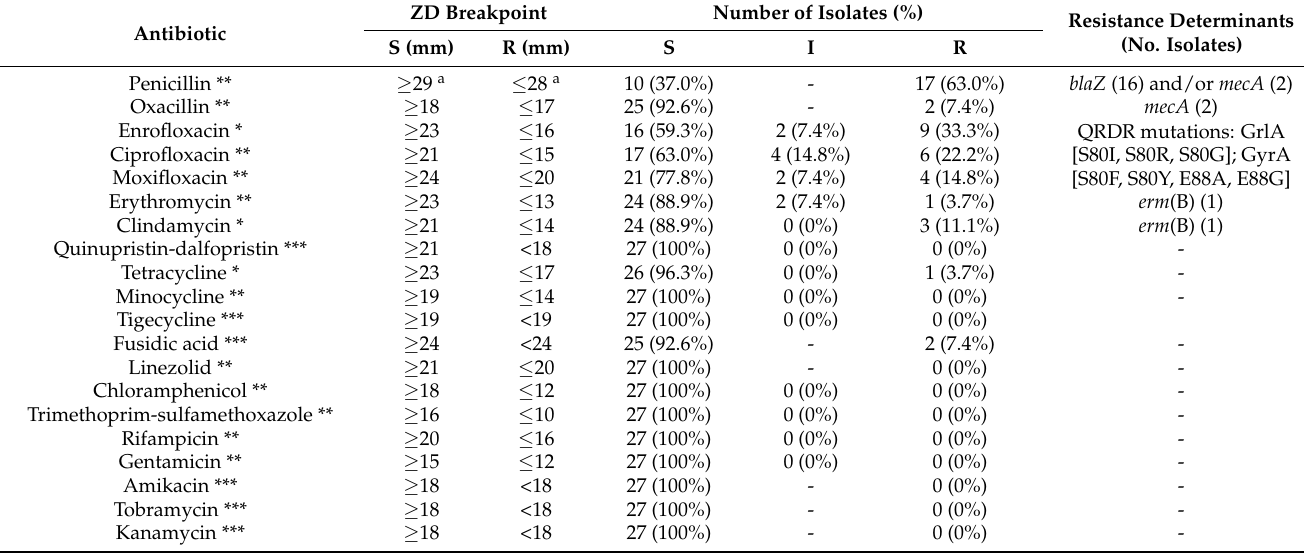
Table 1. Antibiotic susceptibility profiles and antibiotic resistance genes detected for the 27 canine pyoderma associated S. coagulans isolates studied. Data are only presented for antibiotics with established breakpoints. Antibiotic